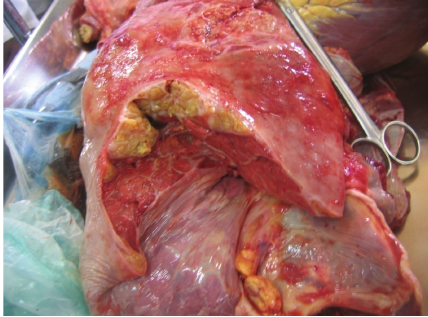
Figure 3: Caseous granulomatous material in the Lung and draining lymph nodes of a cow during routine abattoir surveillance in Namwala District close to the Kafue basin.